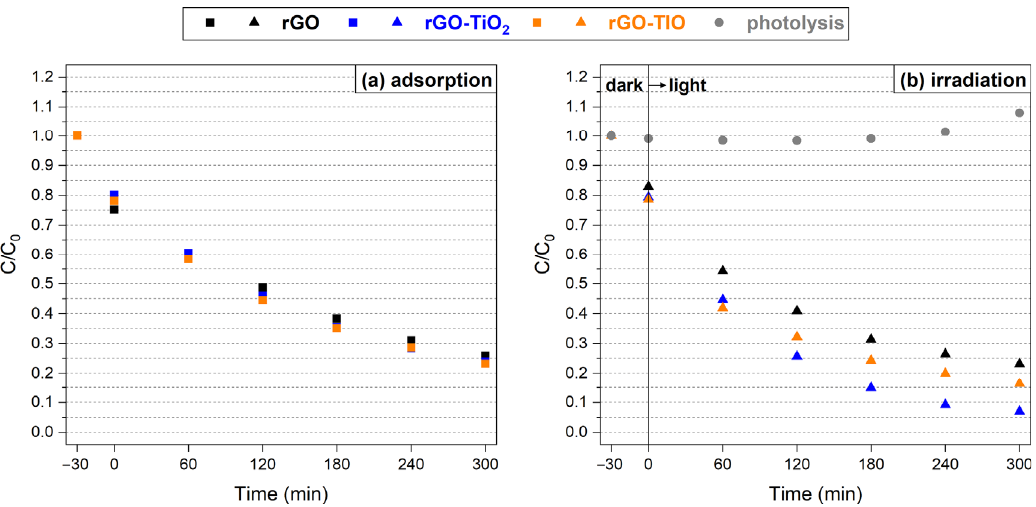
Figure 9. ( a ) Adsorption and ( b ) photolytic/photocatalytic degradation of Imidacloprid ® as a func- tion of time and type of membrane. function of time and type of membrane.